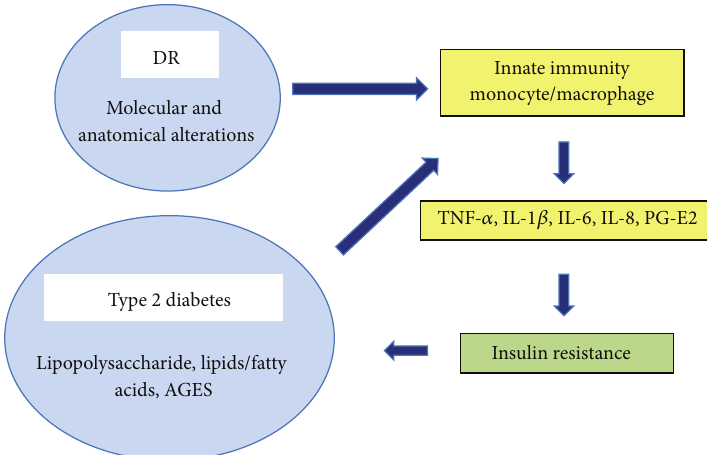
Figure 1: The role of innate immunity in diabetic retinopathy and type 2 diabetes mellitus. In patients with type 2 diabetes and diabetic retinopathy, innate immune markers and proinflammatory cytokines, including IL-1 𝛽 , IL-6, IL-8, TNF- 𝛼 , and prostaglandin E2, are upregulated. The cytokines then enter systemic circulation and contribute to the diabetic pathology by increasing insulin resistance and by elevating blood glucose levels.